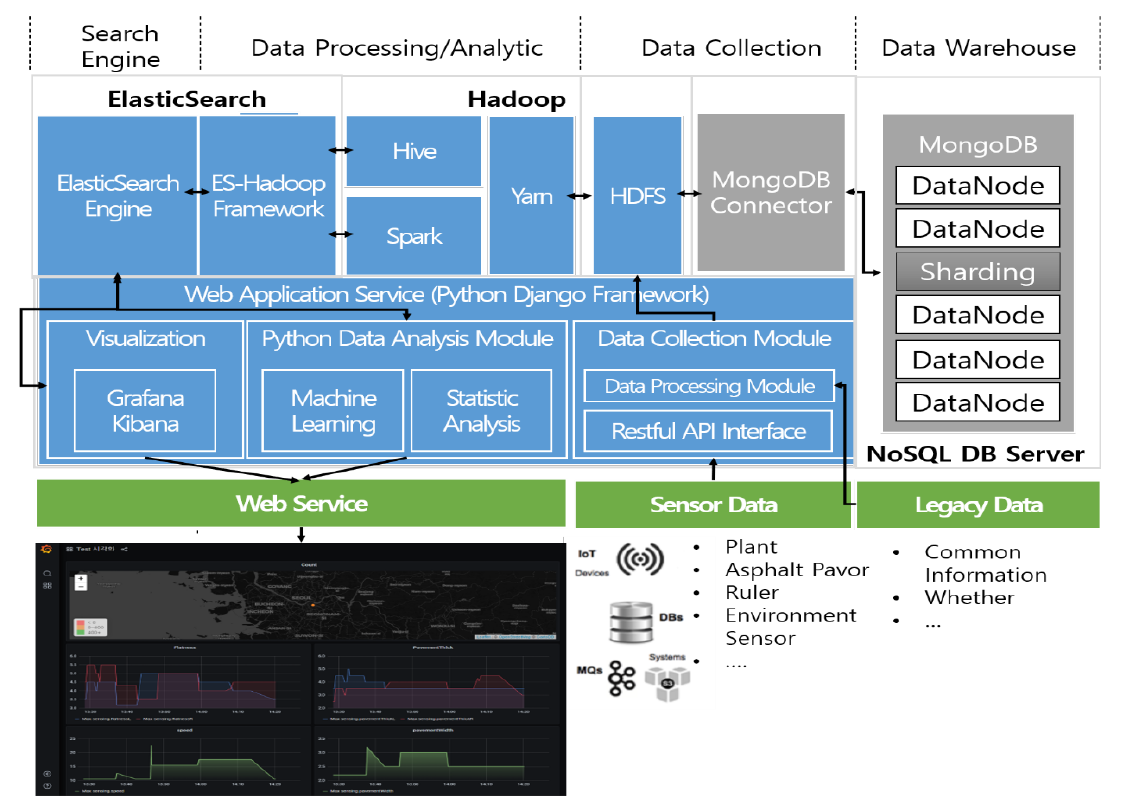
Figure 4. Proposed system.